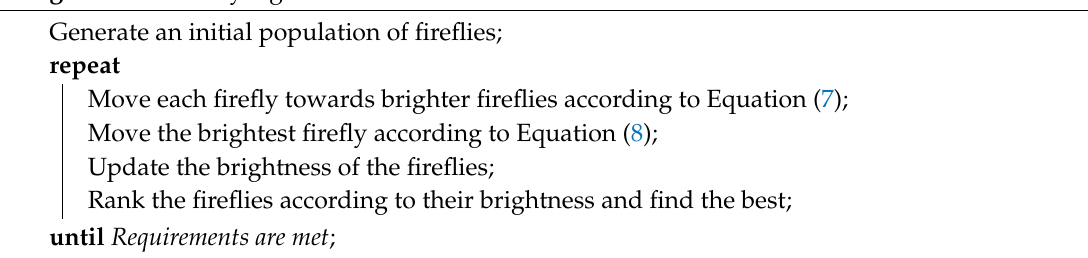
Algorithm 5: Firefly